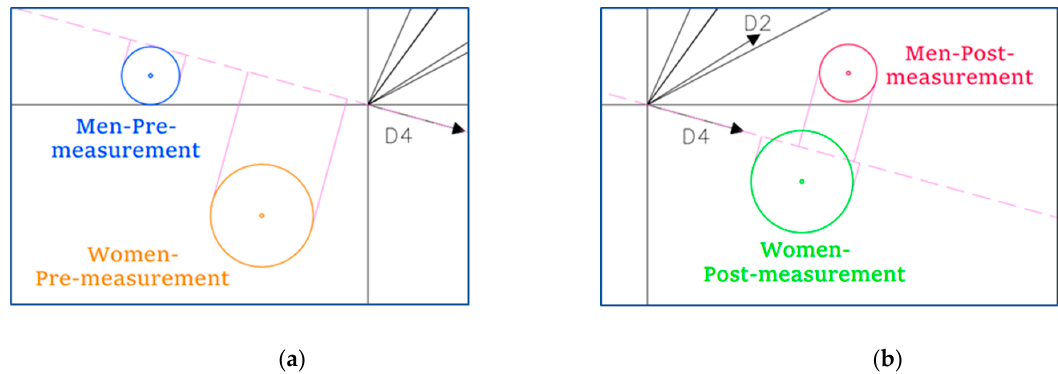
Figure 6. ( a ) Zoom PRE-measurements on D4; ( b ) Zoom POST-measurements on D4.